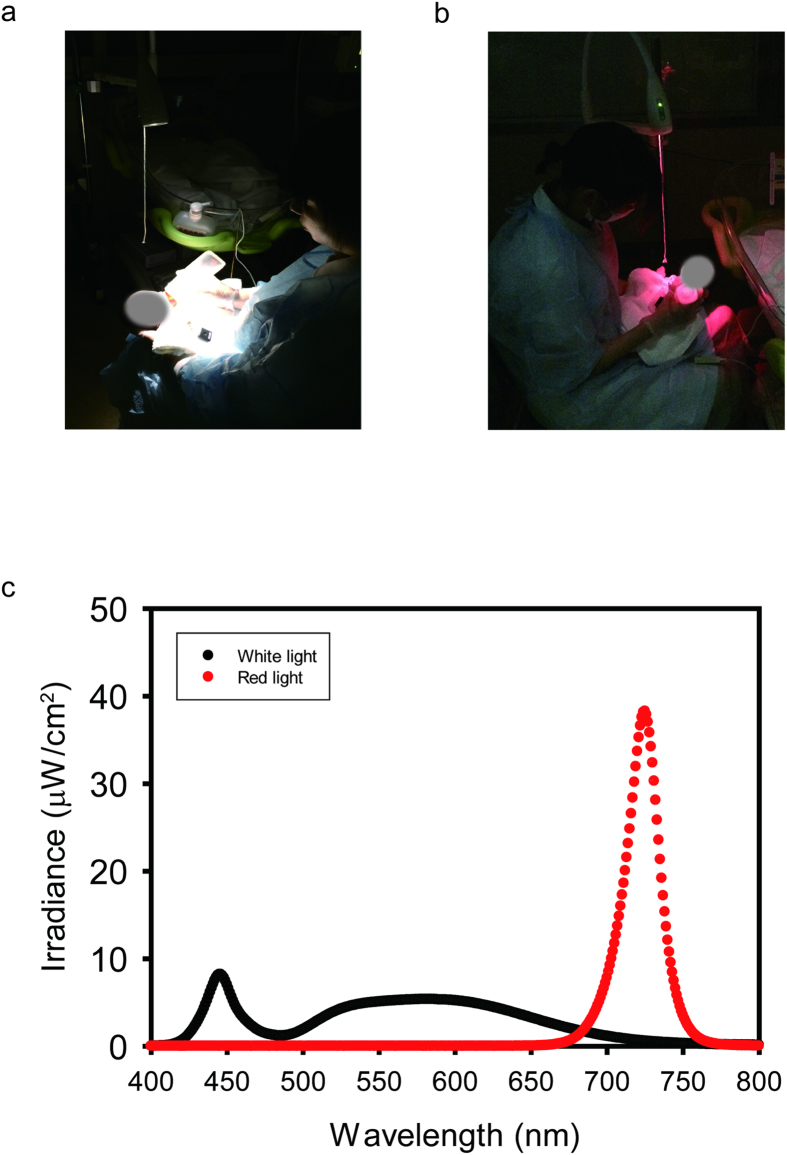
Relative spectral distribution of a white LED light and a red LED light.Representative pictures of nursing care under white LED light (a) and red LED light (b). (c) White line indicates relative spectral distribution of white LED light while red line indicates relative spectral distribution of red LED light. Red LED light has a peak emission of approximately 725 nm.